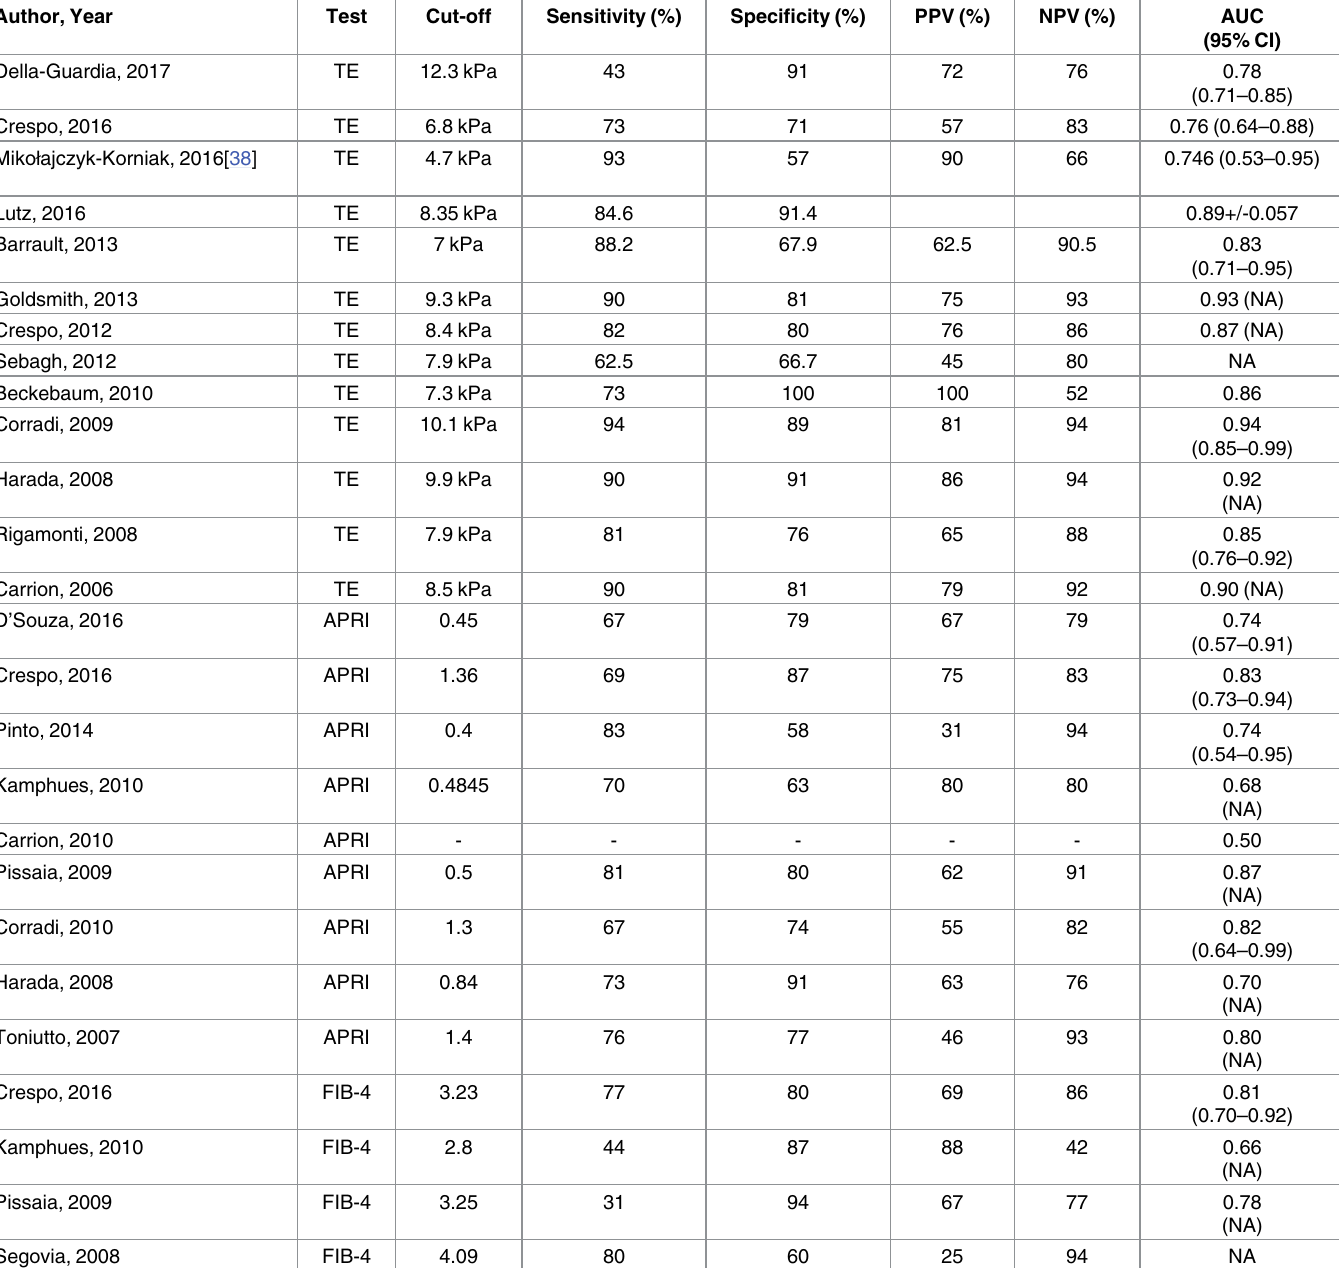
Table 3. Diagnostic accuracyof non-invasive tests to predict fibrosis F2-4 in individual studies included in the meta-analysis. Author,